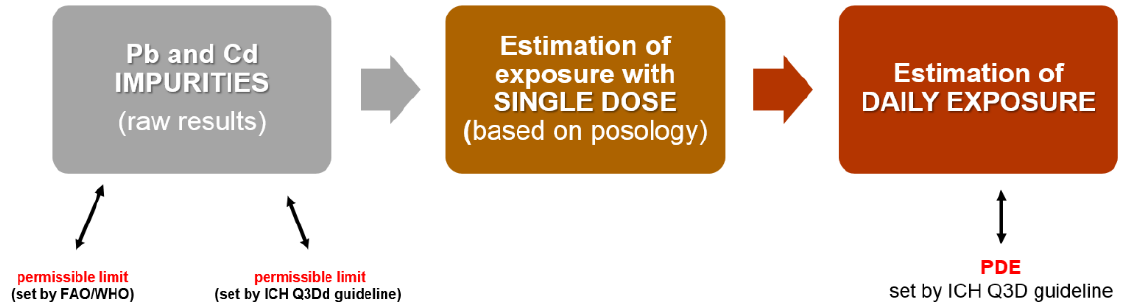
Figure 2. The block diagram of applied strategy for toxicological assessment of Pb and Cd impurities in THMPs with Althaea officinalis L., radix (marshmallow root) available in